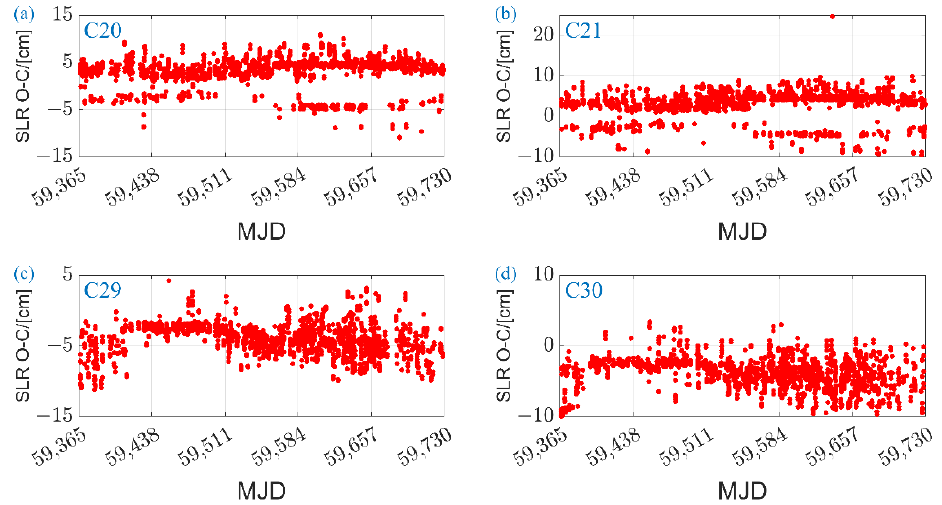
Figure 20. SLR validation results of BDS-3 ( a ) C20 (M2), ( b ) C21 (M3), ( c ) C29 (M9) and ( d ) C30 (M10) orbits.